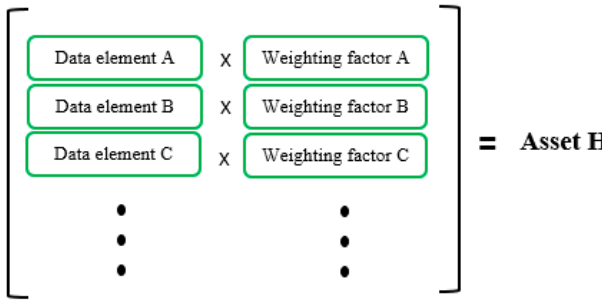
Figure 1. A basic framework of health index formulation.